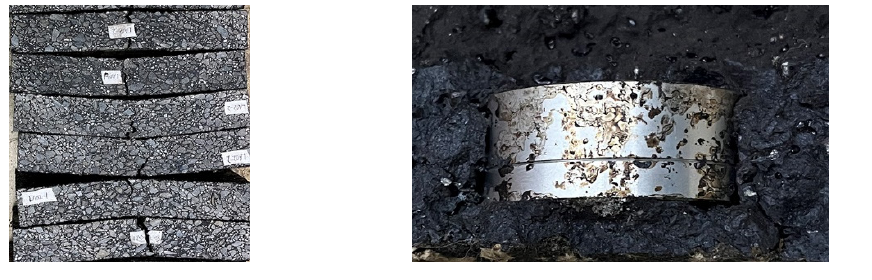
Figure 8. Specimen failure after the three-point bending test.